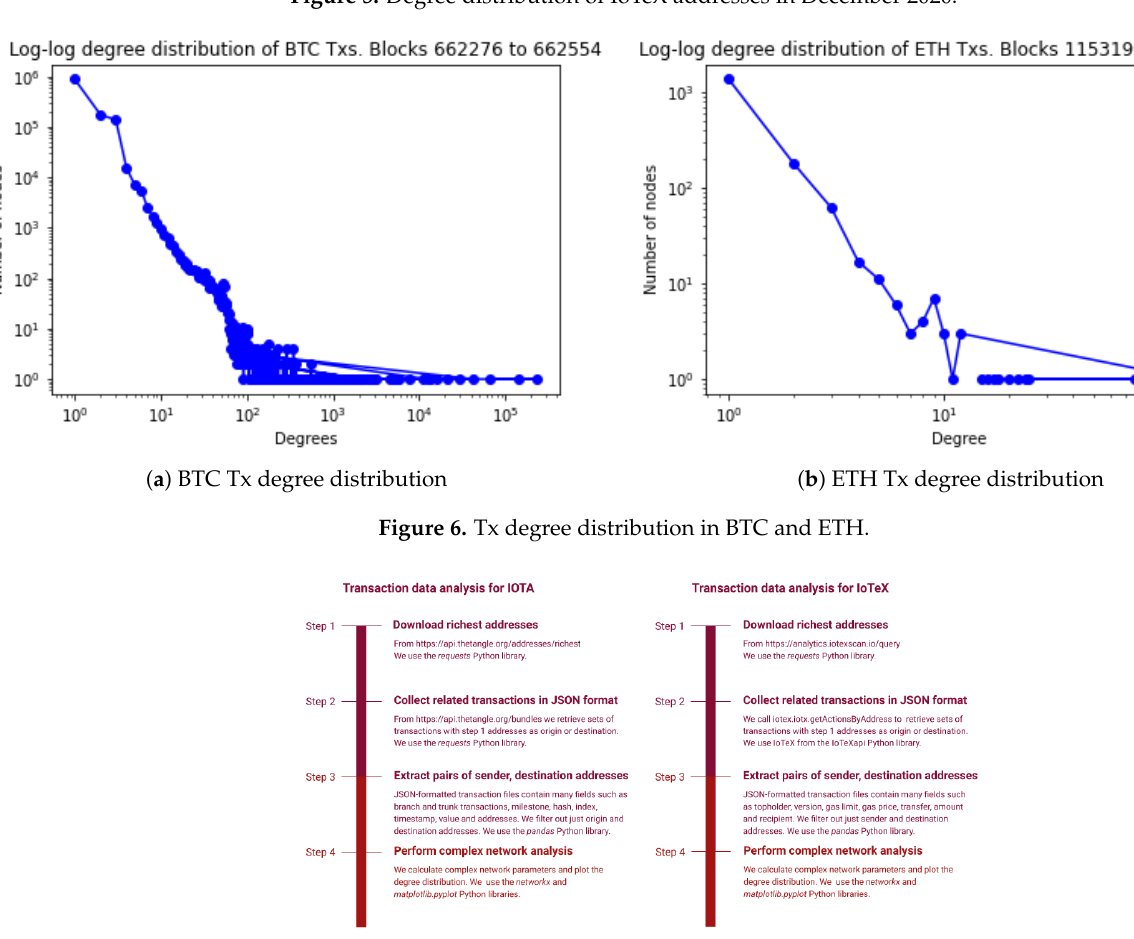
Figure 7. Steps taken to perform the IOTA and IoTeX transaction network